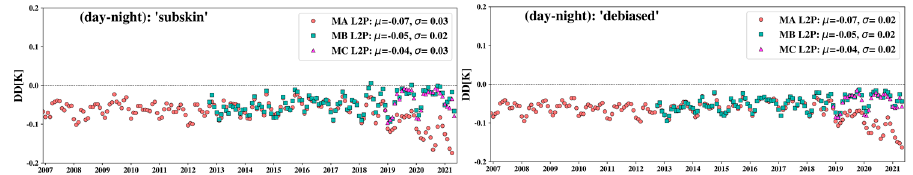
Figure 16. Time series of global monthly aggregated (day ACSPO – L4 CMC) minus (night ACSPO – L4 CMC) SST Double Differences. ( Left ) GR; ( right ) PWR.